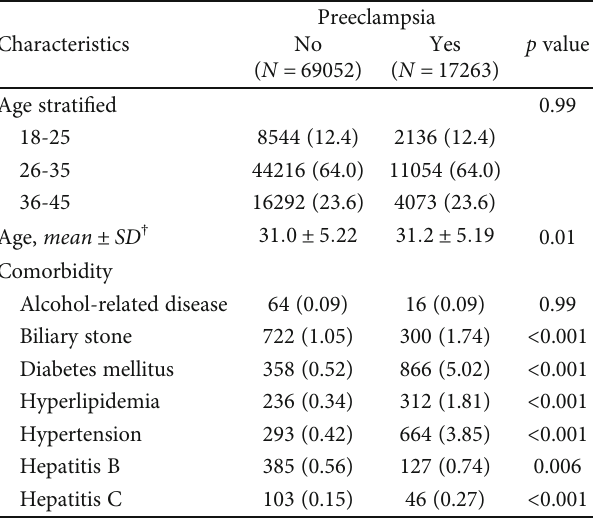
Table 1: Demographic characteristics and comorbidities in patients with and without